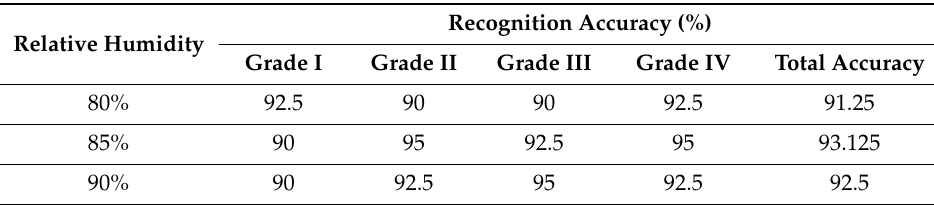
Table 3. Recognition results of SAE–DBN.